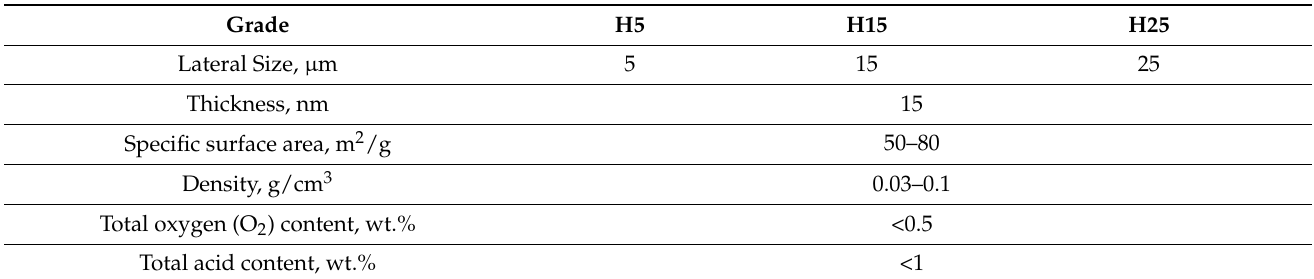
Table 1. Technical data sheet of the purchased GNPs.